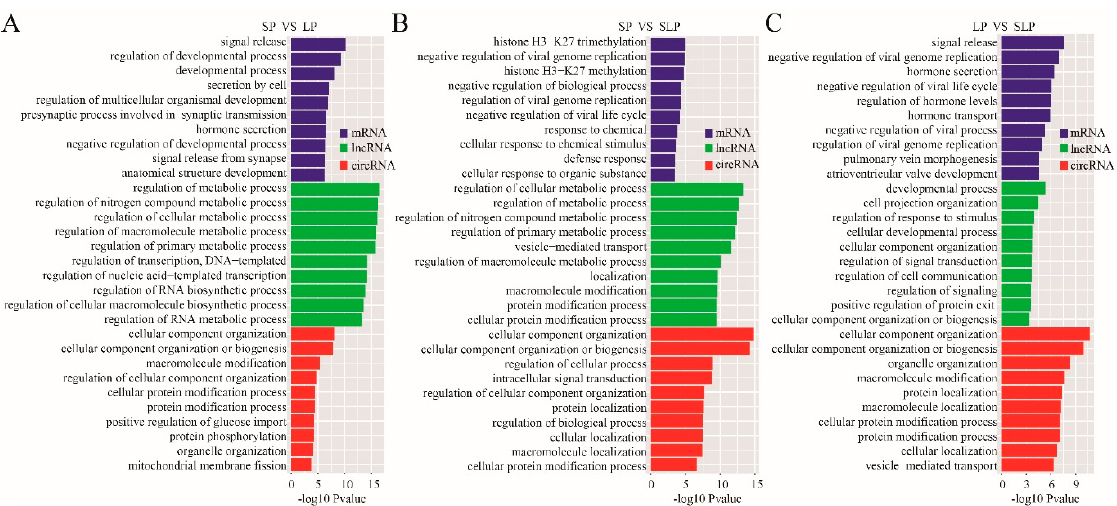
Figure 2. GO analyses of differentially expressed mRNAs, lncRNA targets, and circRNA host genes. ( A ) The top 10 enrichment biological processes for differentially expressed mRNAs, lncRNA targets, and circRNA host genes are listed between the SP and LP groups. ( B ) The top 10 enrichment biological processes for differentially expressed mRNAs, lncRNA targets, and circRNA host genes are listed between the SP and SLP groups. ( C ) The top 10 enrichment biological processes for differentially expressed mRNAs, lncRNAs target, and circRNA host genes are listed between the LP and SLP groups.